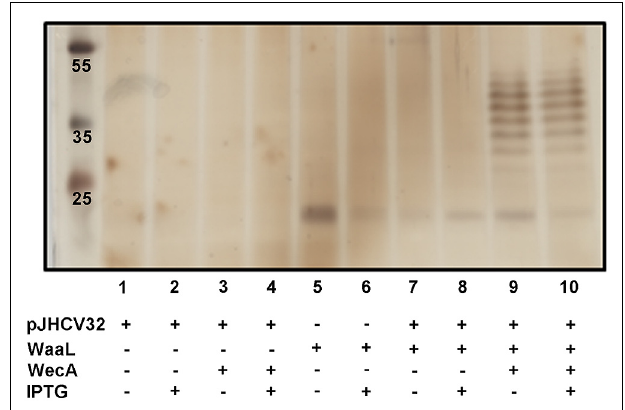
FIGURE 3 | Confirmation of a wecA- waaL- double mutant (SDB1) in E. coli W3110. To verify the double mutant, LPS extractions (20 μ l per sample) were analyzed by silverstain for the ability to produce exogenously expressed E. coli O7 LPS (pJHCV32). No LPS was observed when either WecA orWaaL was expressed in trans (lanes 1–8). However, when both were coexpressed, a laddering pattern was observed, confirming complementation of the double mutant (lanes 9 and 10).